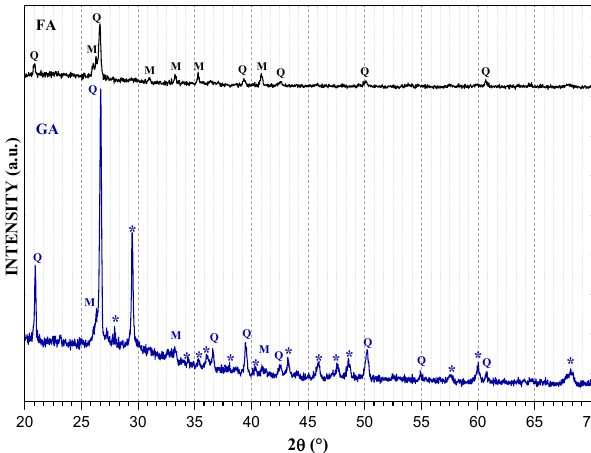
Figure 1. X ‐ ray diffraction (XRD) patterns of blast furnace slag (BFS) and GS. S = Calcium silicate, Q = Quartz, C = Calcite, G = Gehlenite, X = Magnesite, * = calcium aluminosilicate hydrated (CASH) and sodium aluminosilicate hydrated (NASH) type gels.